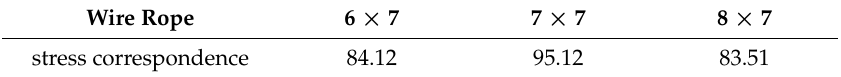
Table 1. Correspondence of analytically and numerically obtained stress values [%].